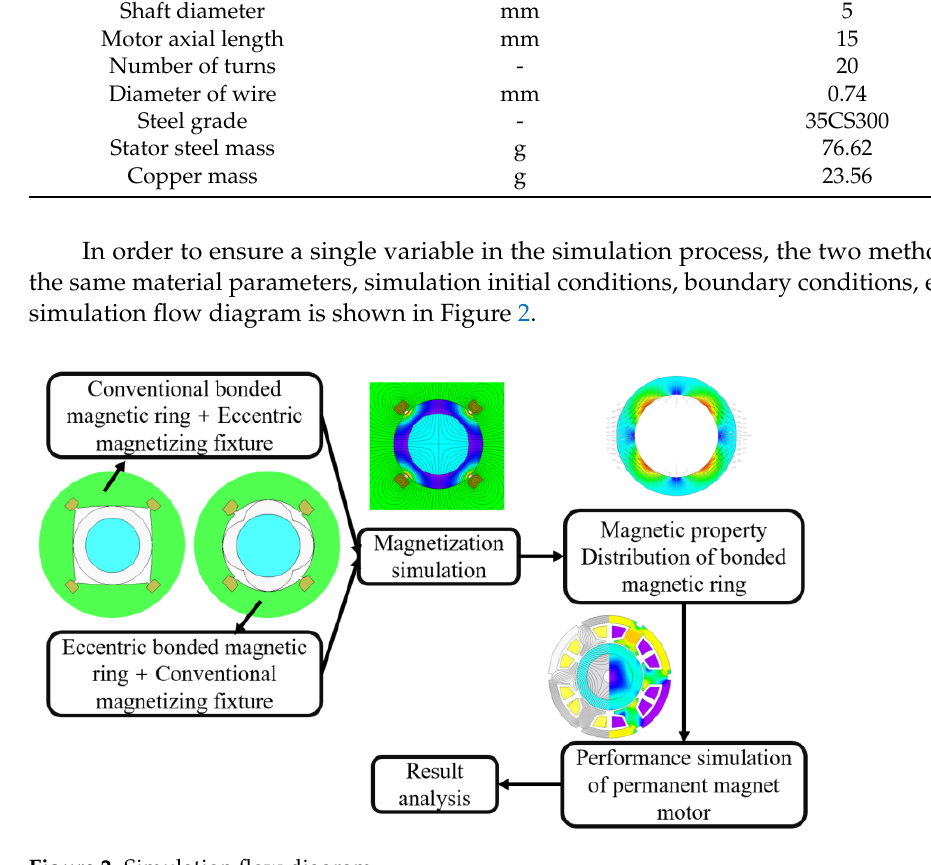
Figure 2. Simulation flow diagram.